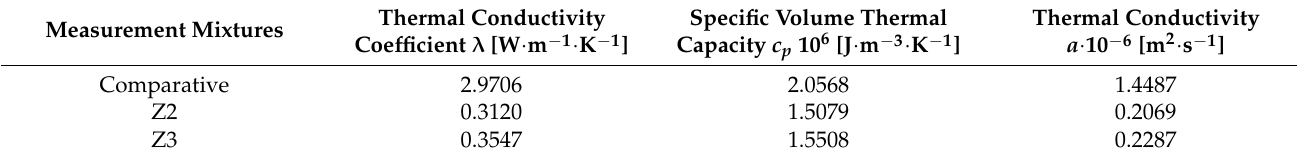
Table 4. Determination of thermal properties of comparative